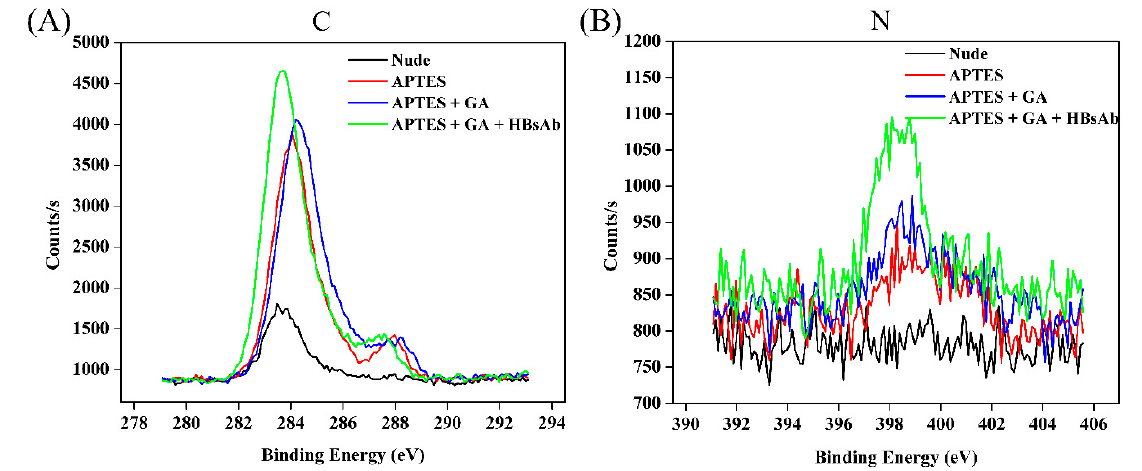
Figure 2. XPS carbon and nitrogen spectrum of silicon wafer (Si-wafer) surface modification, and HBsAb immobilization procedure. Nude, APTES, APTES + GA, and APTES + GA + HBsAb indicate the Si-wafer without surface modification, after being treated with APTES, after being treated with APTES and glutaraldehyde, and after being treated with APTES, glutaraldehyde, and HBsAb, respectively. ( A ) Carbon XPS spectra and ( B ) Nitrogen XPS spectra at each immobilization step.